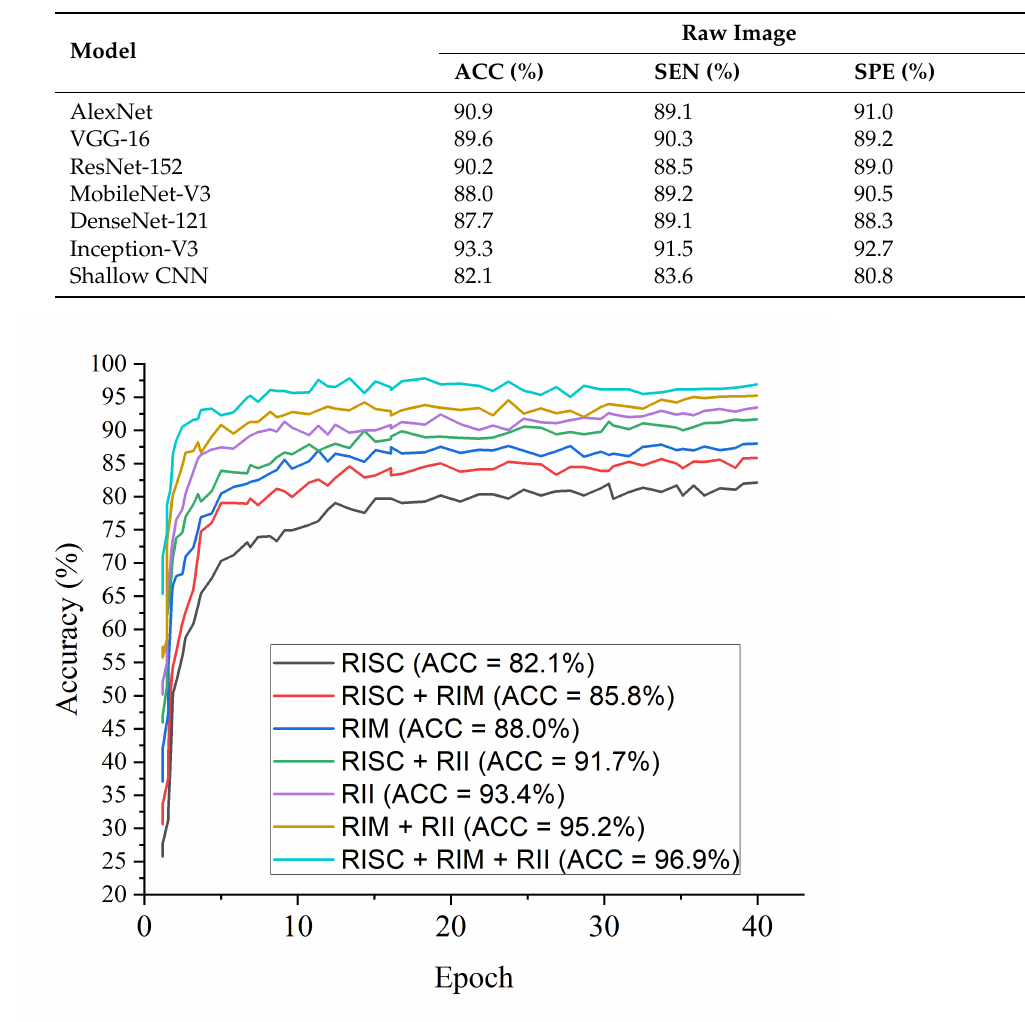
Table 12. Performance results obtained using the raw chest X-ray images on different pretrained models on our proposed model.